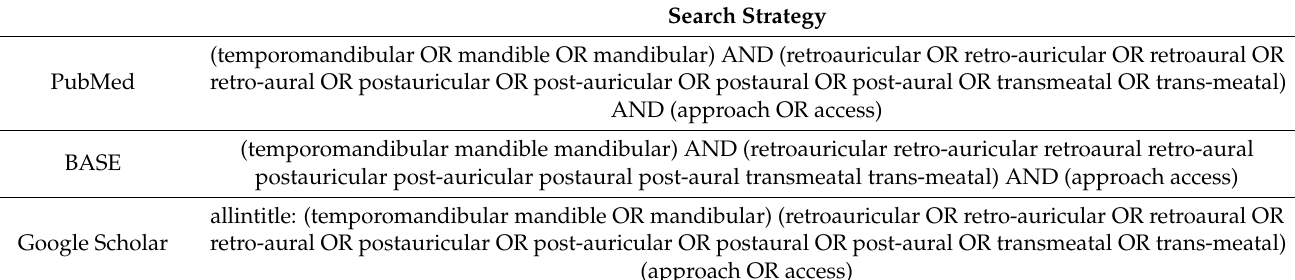
Table 2. Applied search strategies. Description in the text. Search